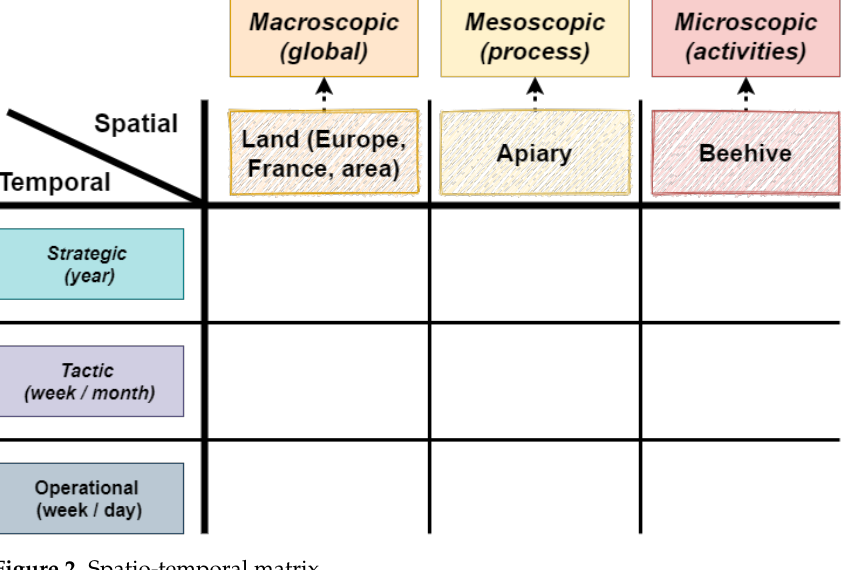
Figure 2. Spatio-temporal